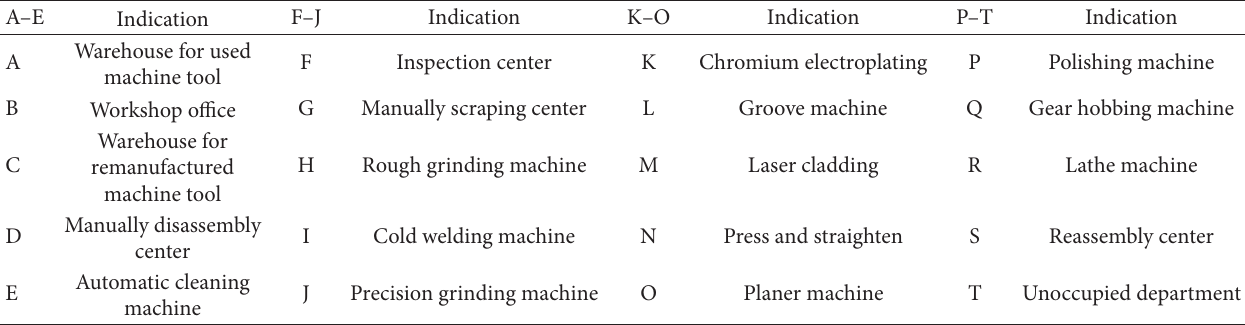
Table 2: The detailed indication of the letters A–T in Figures 5 and